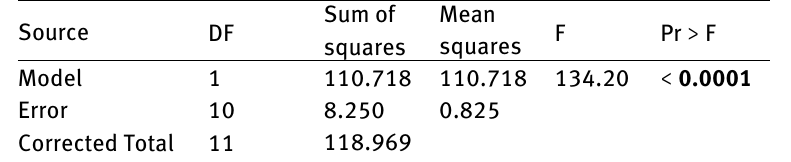
Table 10: Analysis of variance (Compressive Strength Model (Mpa))